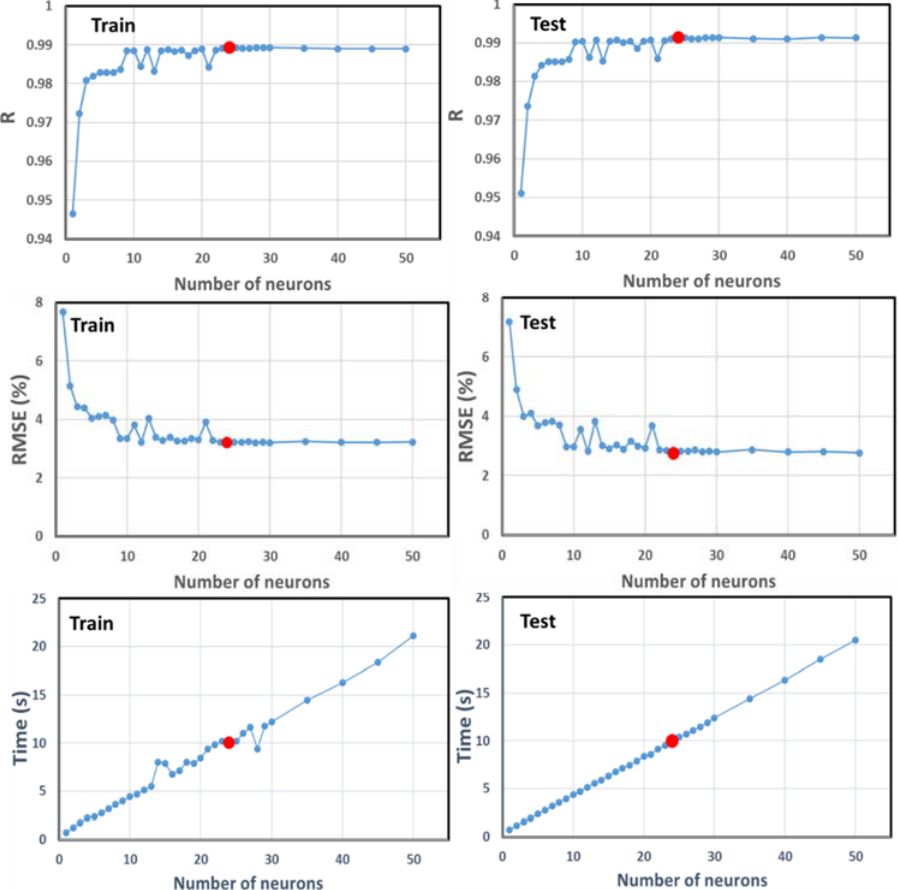
Figure 4. MLP performance with the different number of neurons in the hidden layer over the training and testing phases. In each plot, the red ‐ colored circle indicates the optimum number of neurons based on the highest R and lowest RMSE.